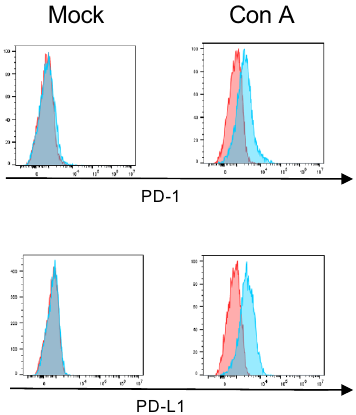
Figure 4. PD-1 and PD-L1 expression in stimulated feline lymphocytes. Peripheral blood lymphocytes were isolated from the peripheral blood and stimulated with 10 µg/mL of concanavalin A (Con A) for 48 h. After culture, the cells were collected and stained with anti-PD1 (1A1-2) mAb or anti-PD-L1 (G11-6) mAb, followed by anti-mouse IgG-alexa647 or anti-rat IgG-DyLight649 antibodies, respectively.